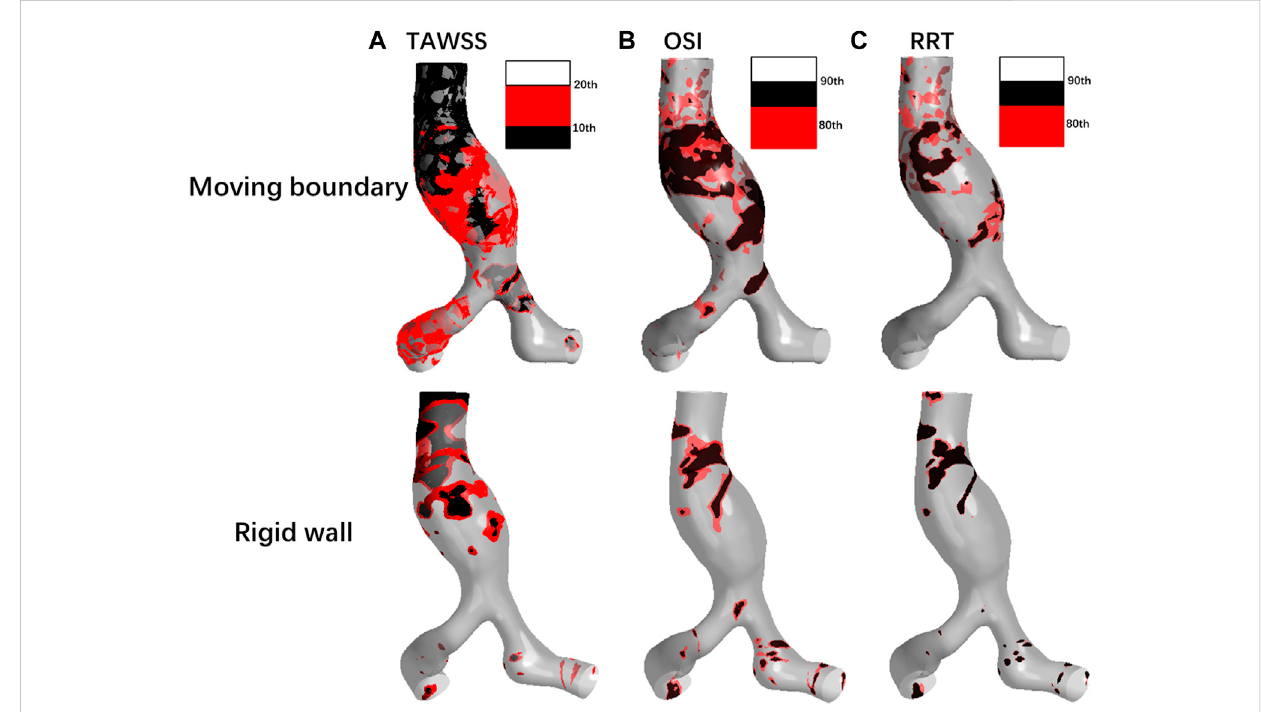
FIGURE 9 Comparison of (A) TAWSS, (B) OSI, and (C) RRT distributions by using two